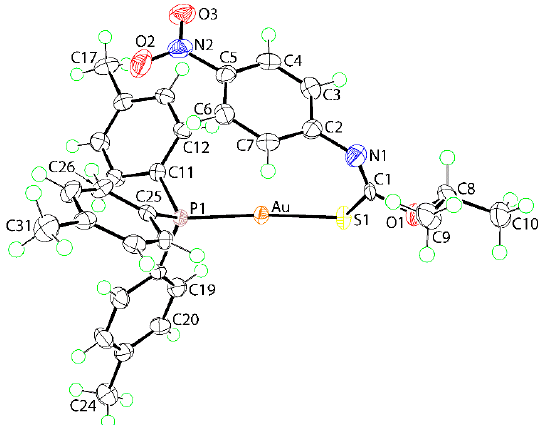
Figure 1. The molecular structure of 1 showing atom labelling and displacement ellipsoids at the 70% probability level. Selected geometric parameters: Au ‒ S1 = 2.2993(12), Au ‒ P1 = 2.2649(12), C1 ‒ S1 = 1.771(5), C1 ‒ O1 = 1.348(6), C1=N1 = 1.260(8) Å; Au ‒ S1 ‒ C1 = 107.33(16), S1 ‒ C1 ‒ O1 = 108.3(4), S1 ‒ C1 ‒ N1 = 131.1(4), O1 ‒ C1 ‒ N1 = 120.5(5)°.